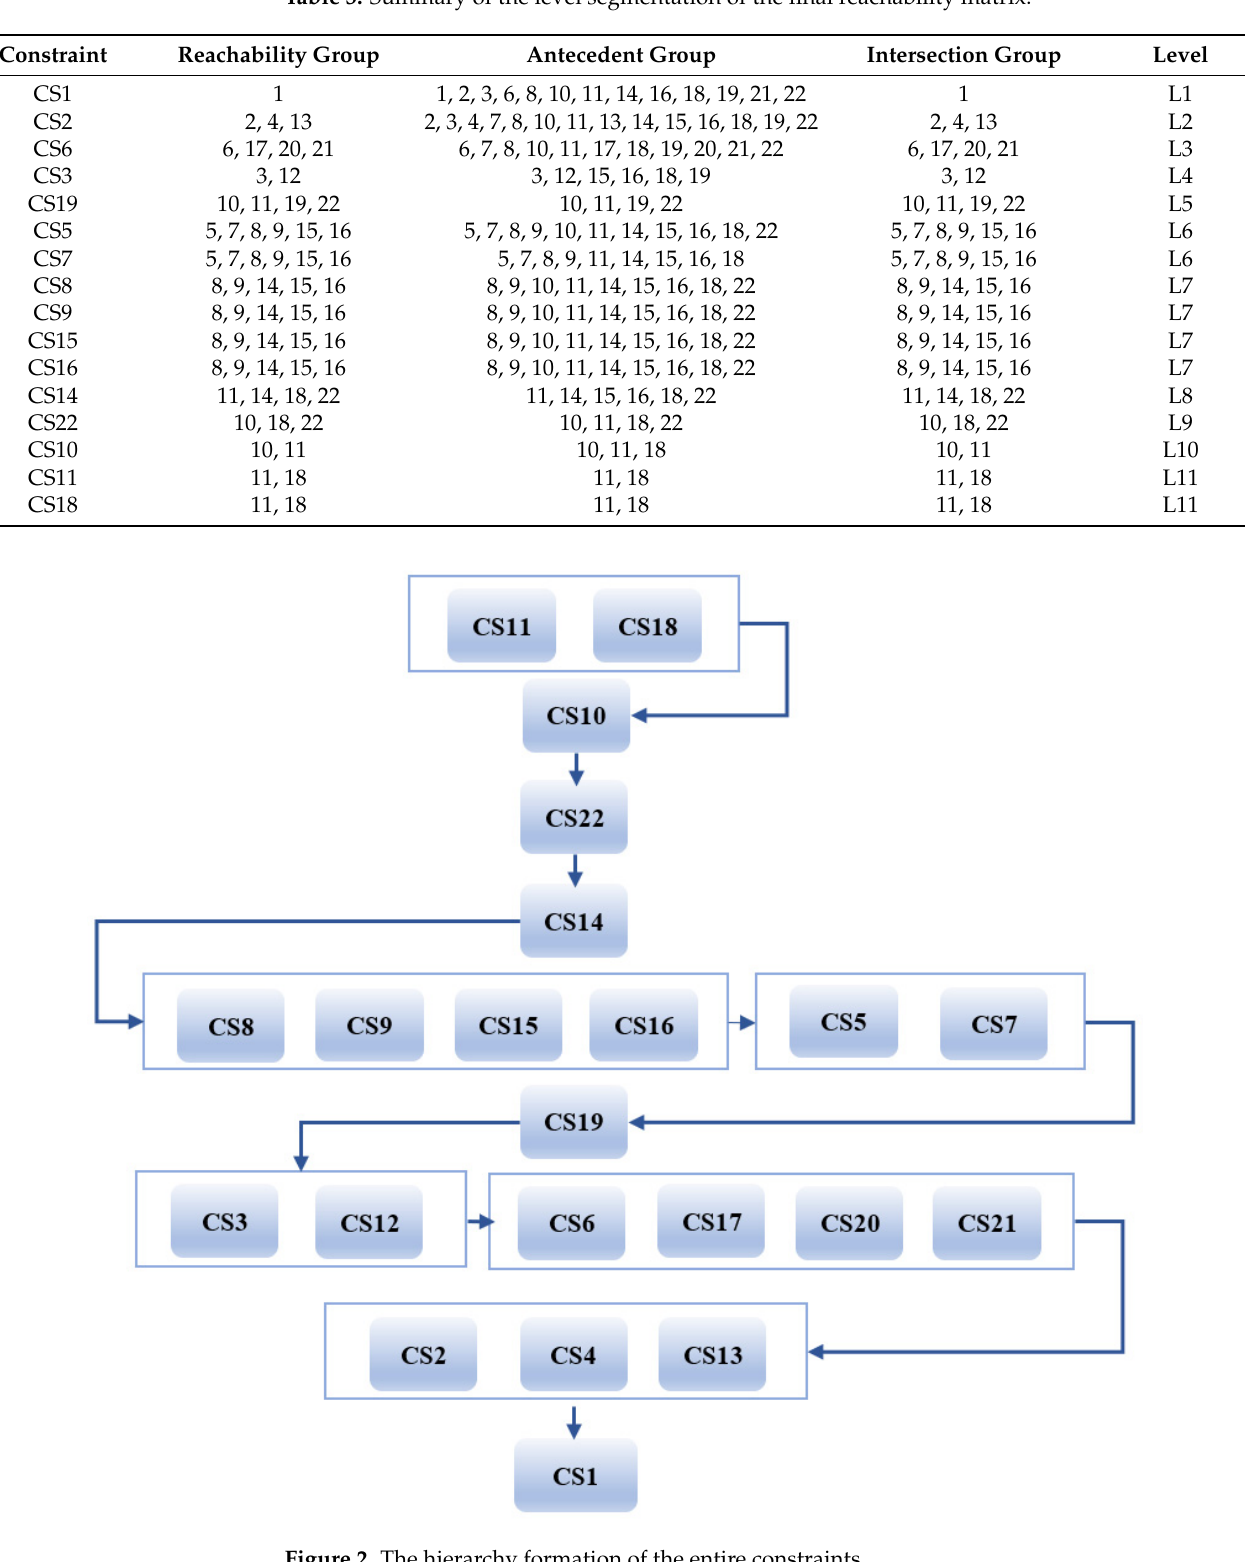
Figure 2. The hierarchy formation of the entire constraints. Table 4. Level segmentation for the complete constraints.